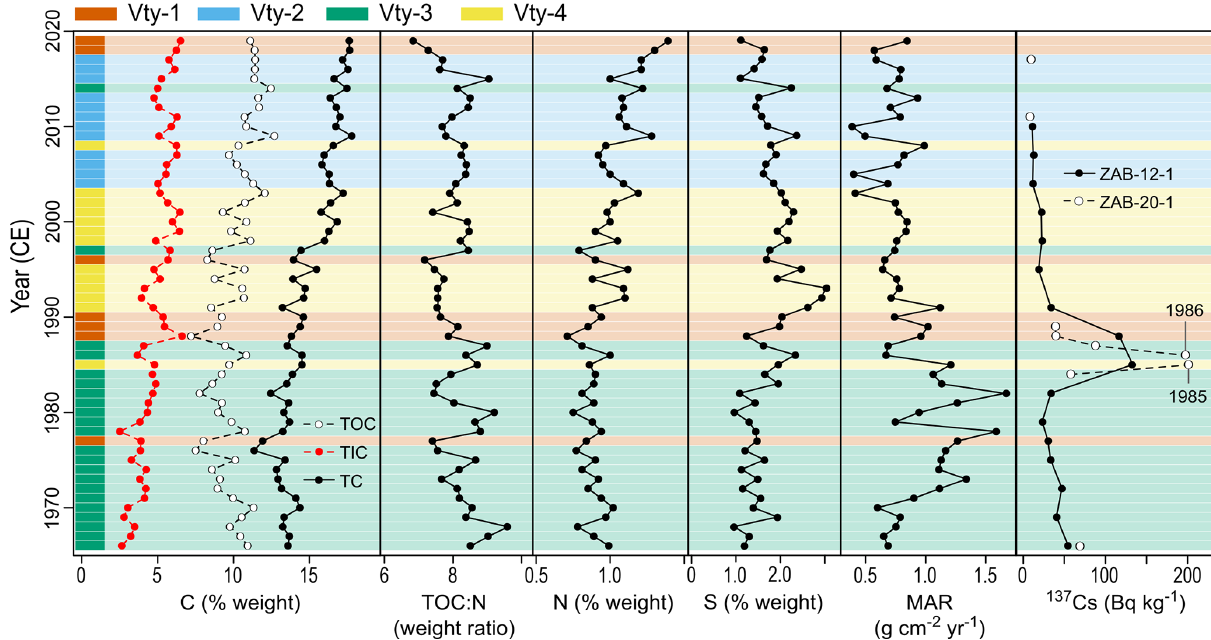
Figure 2. Results of CNS elemental analysis, mass accumulation rates, and 137 Cs activities displaying the 1986 peak from the Chernobyl accident. See Sect. 3.3 for an explanation of the Varve Types